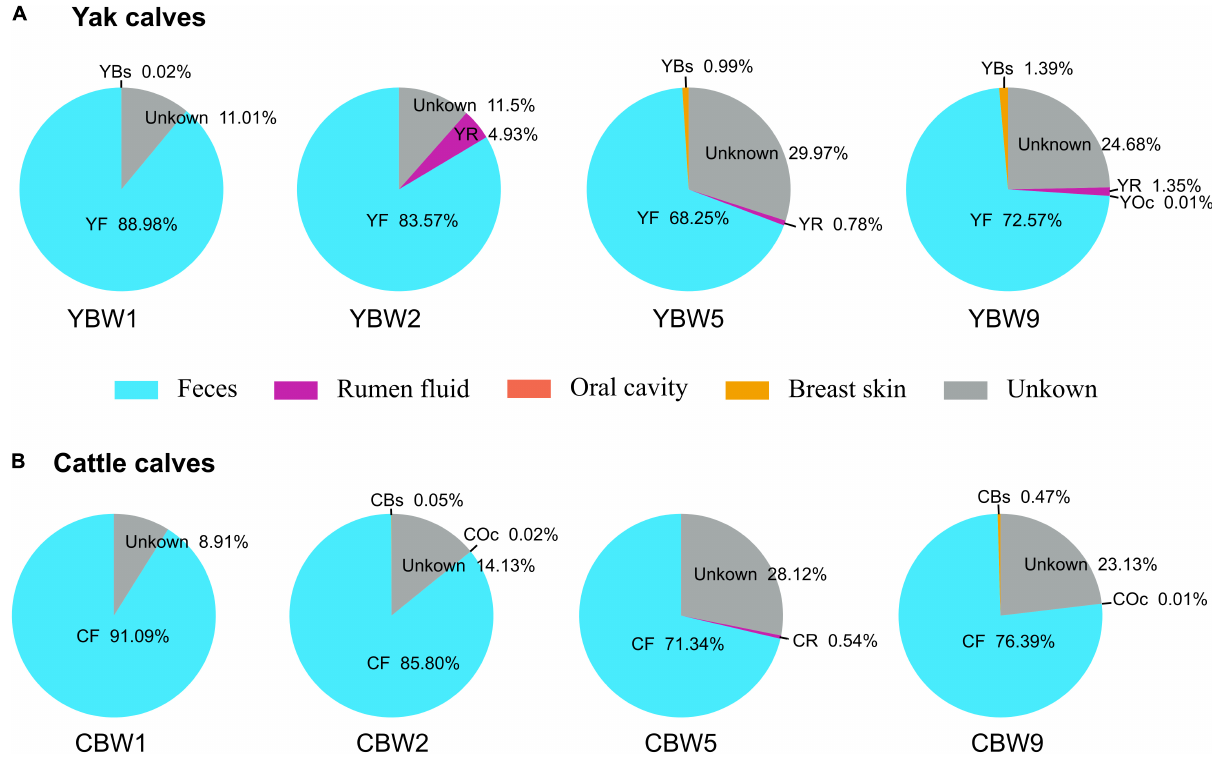
FIGURE 4 | Source Tracking model of the maternal sources in early calf intestinal community assembly. We used SourceTracker2 to estimate the proportion of sequences in the intestinal microbiota of both yak (A) and cattle calves (B) at different weeks after birth that originated from their maternal microbial communities. YBW1F, YBW2F, YBW5F, and YBW9F represent fecal samples from yak calves at weeks 1, 2, 5, and 9 after birth; CBW1F, CBW2F, CBW5F, and CBW9F represent fecal samples from cattle calves at weeks 1, 2, 5, and 9 after birth. YR, YF, YBs, and YOc represent rumen fluid, feces, breast skin and oral cavity samples from